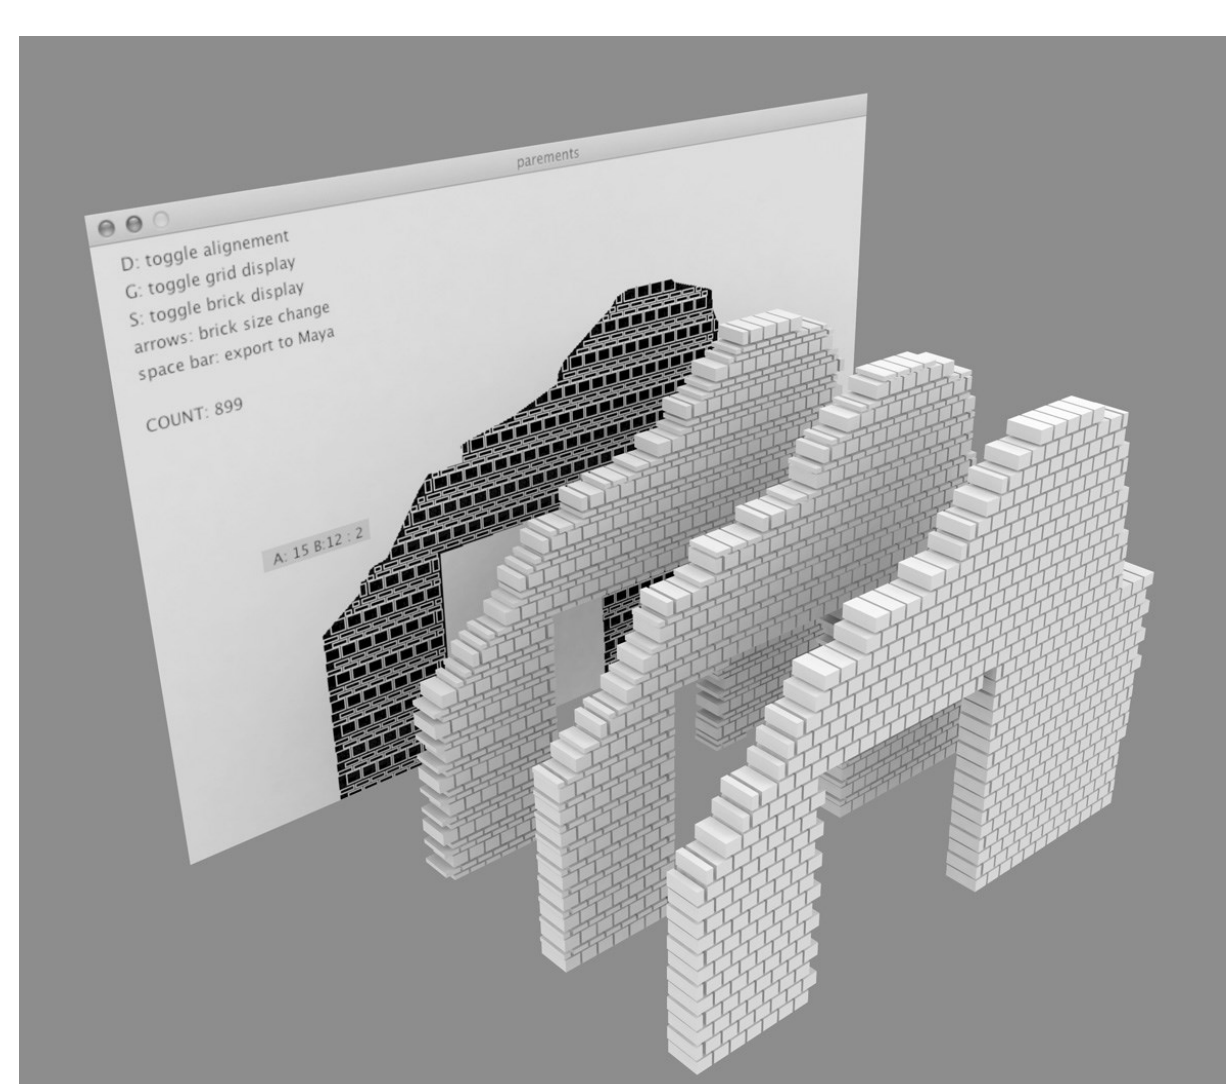
Figure 5. Opus types: from Processing to 3D Maya